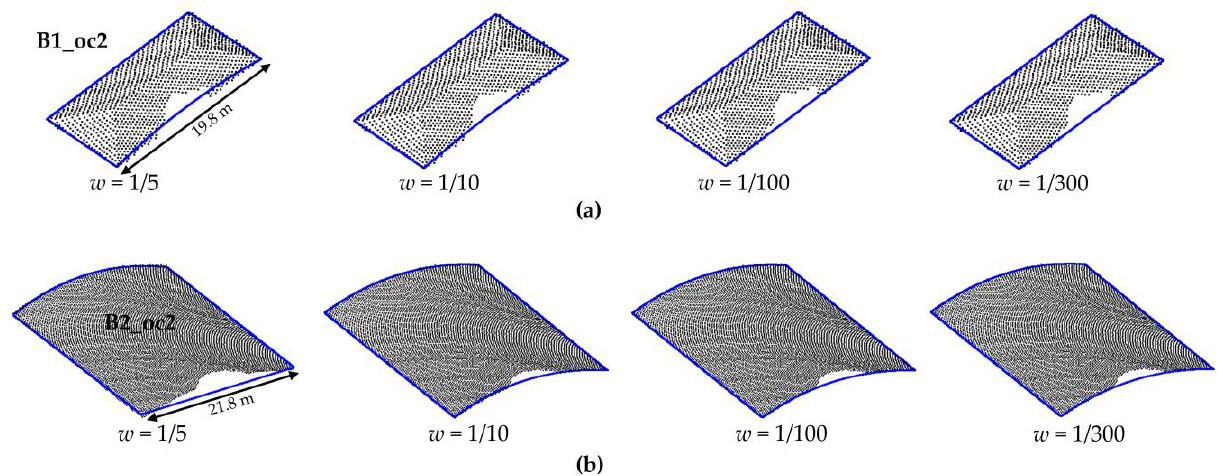
Figure 9. Modeled contour for buildings B1_oc2 ( a ) and B2_oc2 ( b ) using different weight values.